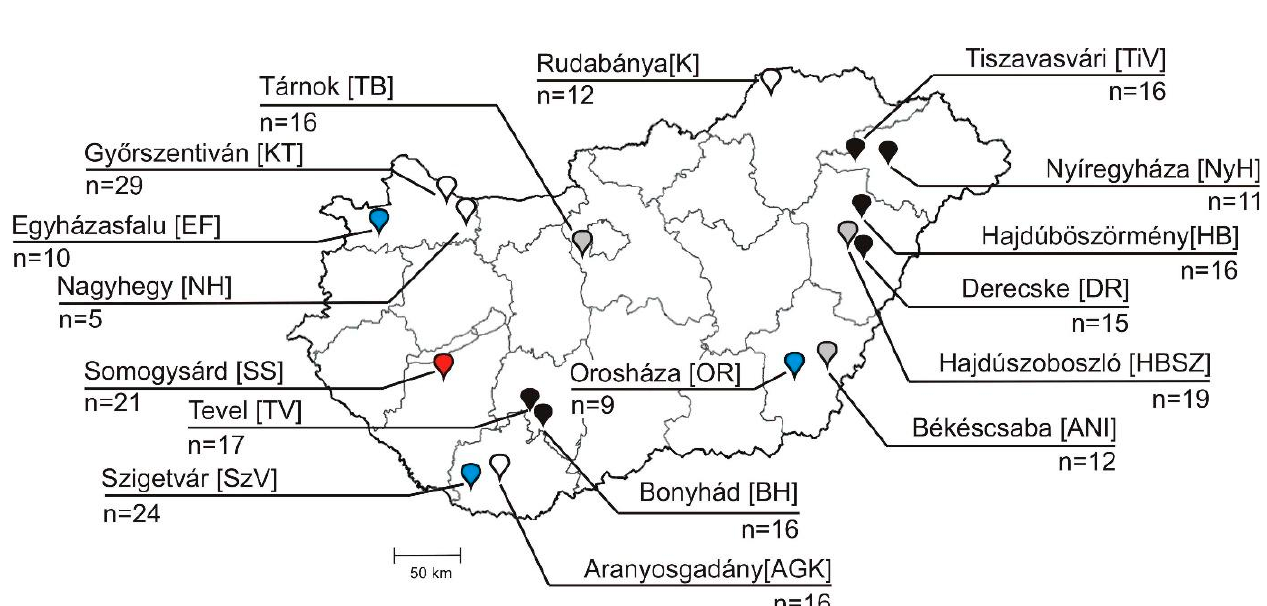
Figure 1. Localisations with farm IDs (in square brackets) and numbers of collected faecal samples (n = 269) of different Hungarian animal farms used for investigation of bopiviruses. Empty markers: caprine farms, black markers: bovine farms, grey markers: ovine farms, red marker: rabbit farm, blue markers: swine farms. The majority of the investigated farms were “large-scale industrial livestock farms”, in which ≈ 100 to >1000 animals were housed together, except caprine farms of Nagyhegy